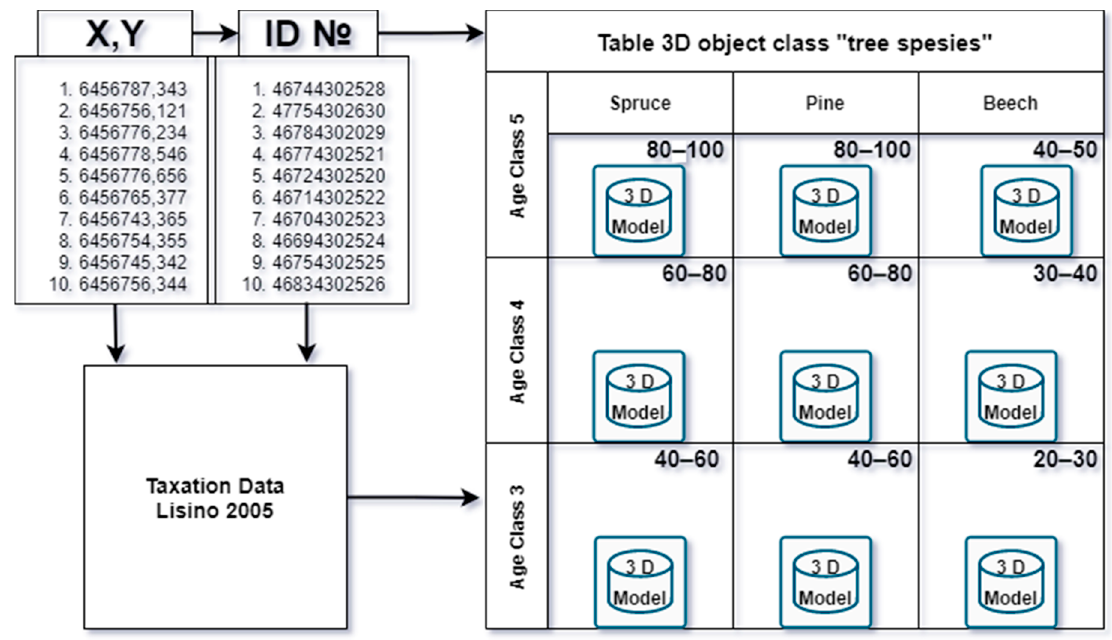
Figure 8. Functional components of the digital model.